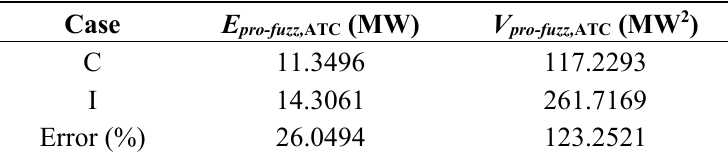
Table 8. The results of Case C and Case